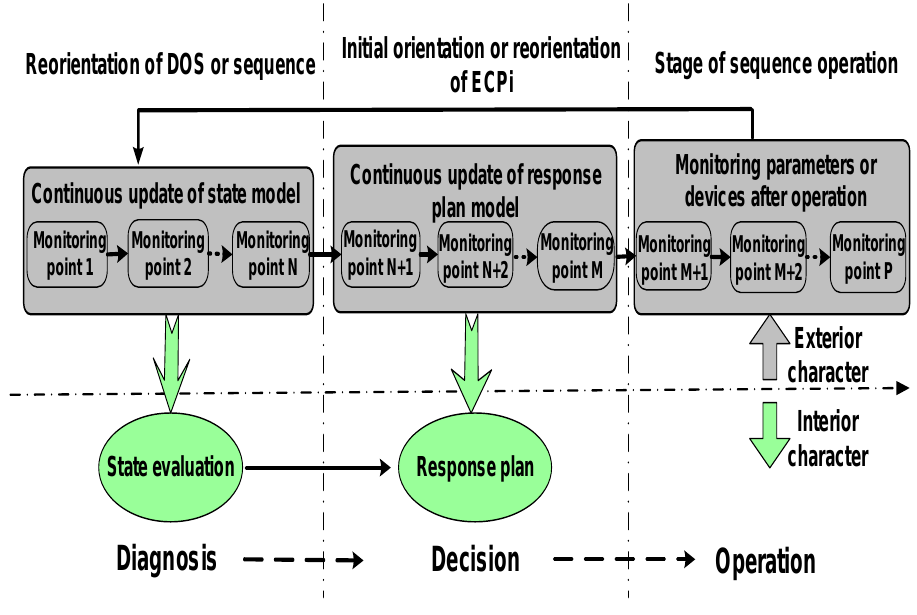
Figure 6. US cognitive behavioral model.